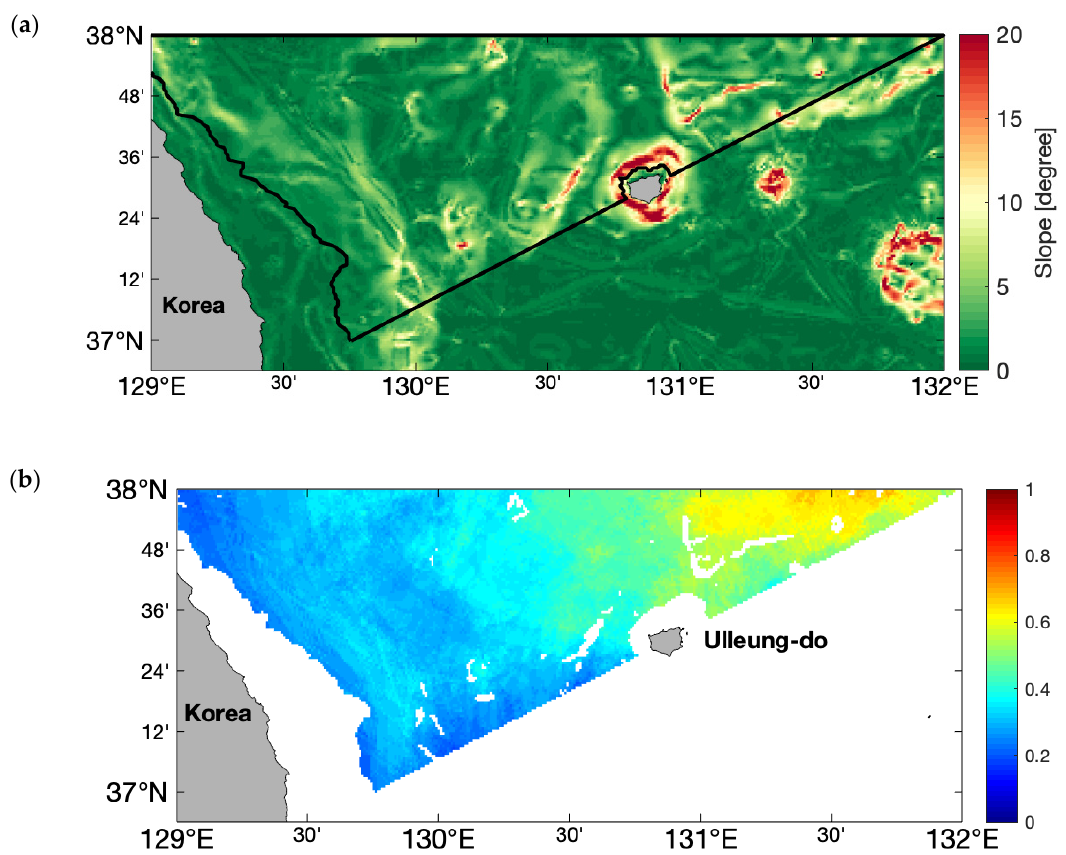
Figure 11. Optimal area for offshore tsunami observation instrument deployment. ( a ) Ocean bottom slope for the higher probability area in the eastern sea of Korea (the black line is the boundary area); ( b ) The product of MLE and probability of tsunami travel time within 1.5 after the earthquake over a flat ocean bottom. The MLE results for 0.1 m maximum tsunami wave height.